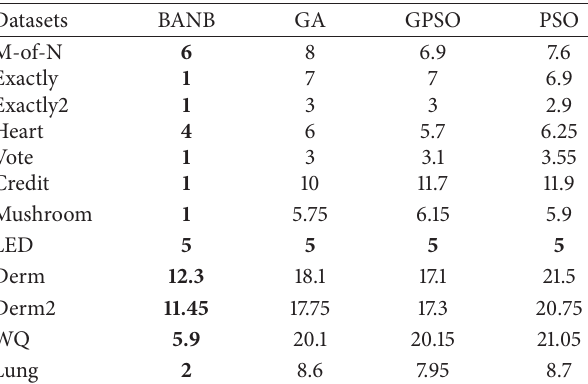
Table 2: Average of selected features.